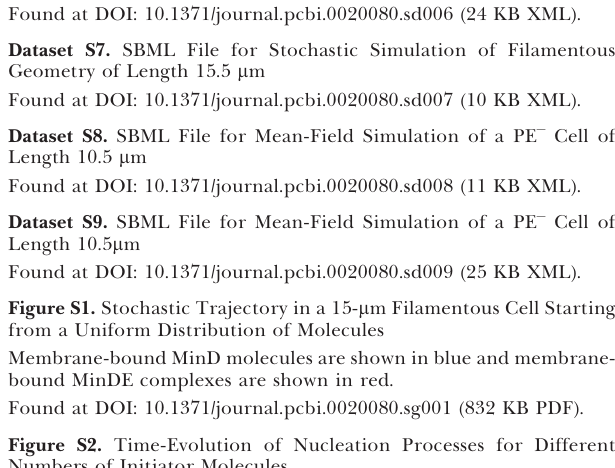
Figure S1. Stochastic Trajectory in a 15- l m Filamentous Cell Starting from a Uniform Distribution of Molecules Membrane-bound MinD molecules are shown in blue and membrane- bound MinDE complexes are shown in red. Figure S2. Time-Evolution of Nucleation Processes for Different Numbers of Initiator Molecules The stochastic model with PE (cid:1) parameters was solved for a box (5 l m 3 1 l m 3 1 l m), with membrane on the 1- l m 3 1- l m side.